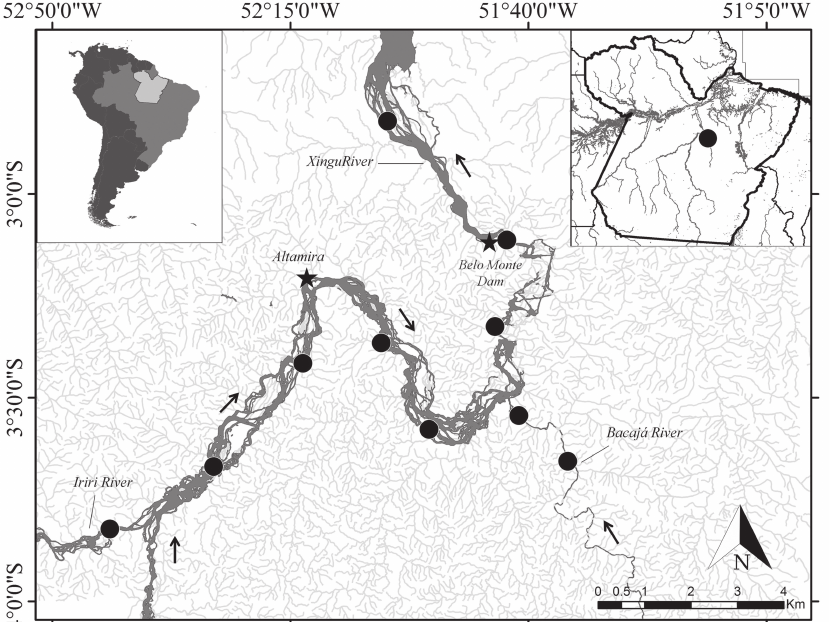
Fig. 1. Study area on the middle Xingu River in Pará, Brazil. The black dots represent the sampling sites, and the arrows indicate the direction of the water